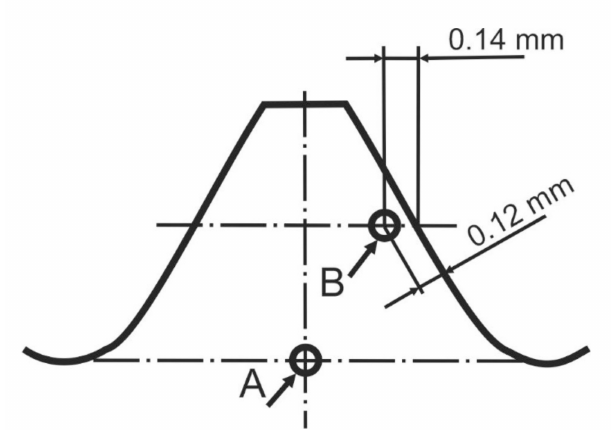
Figure 16. Schematic diagram of the thread section with the marking of microhardness measurement locations in order to state carburization according EN ISO